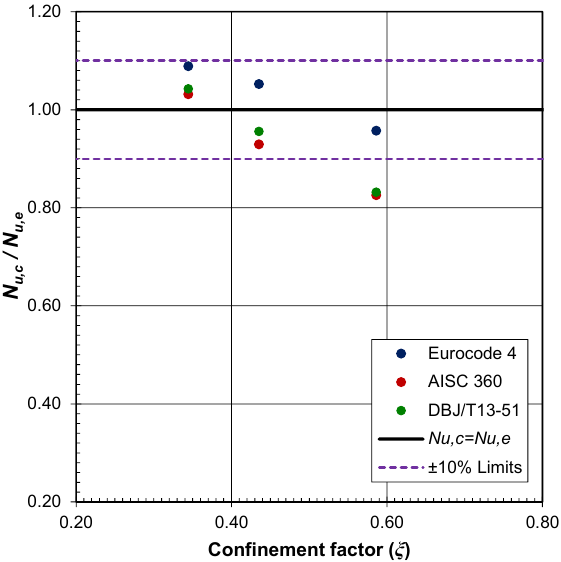
Figure 21. Comparison of axial compressive strengths ratios of the predicted and the test results within the experimental range 0.344–0.586 of ξ .